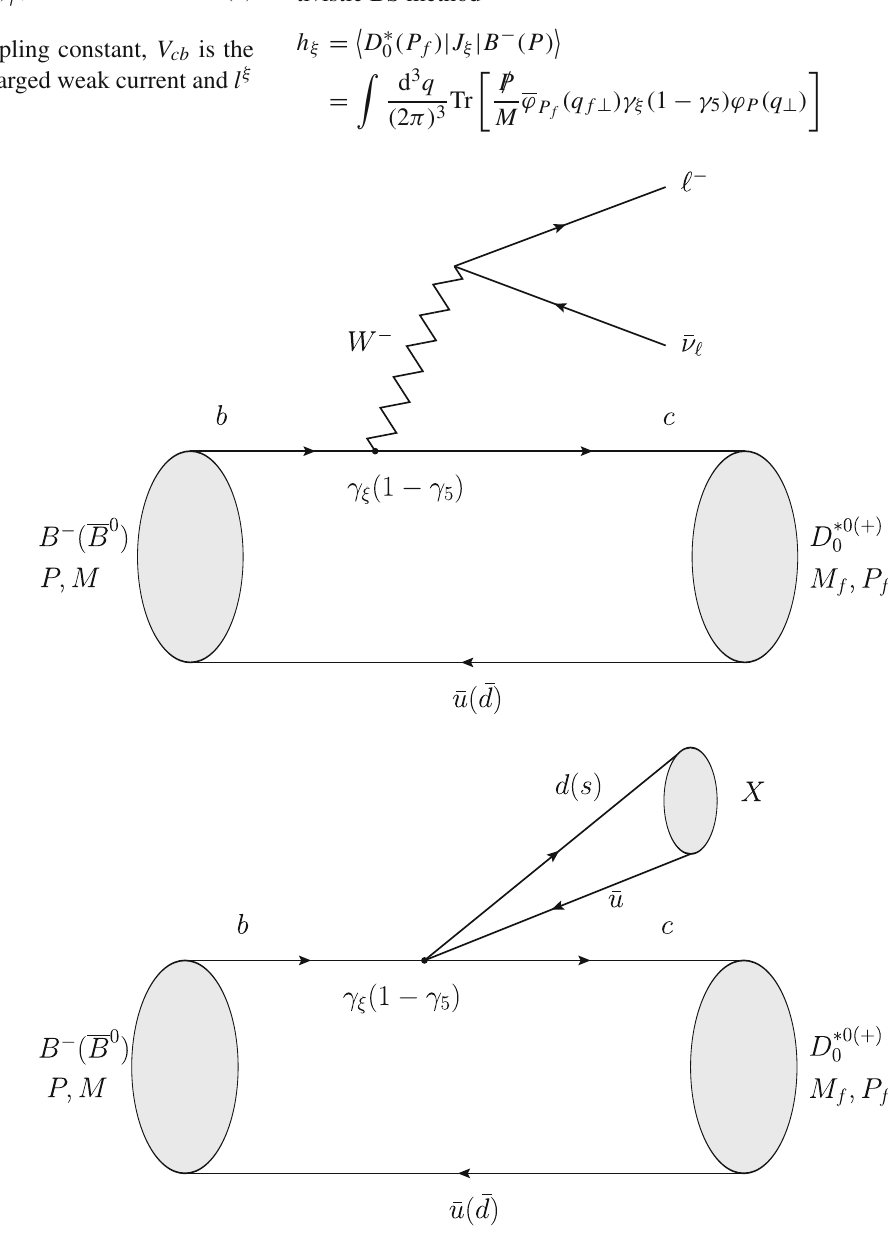
Fig. 2 Feynman diagram of the non-leptonic